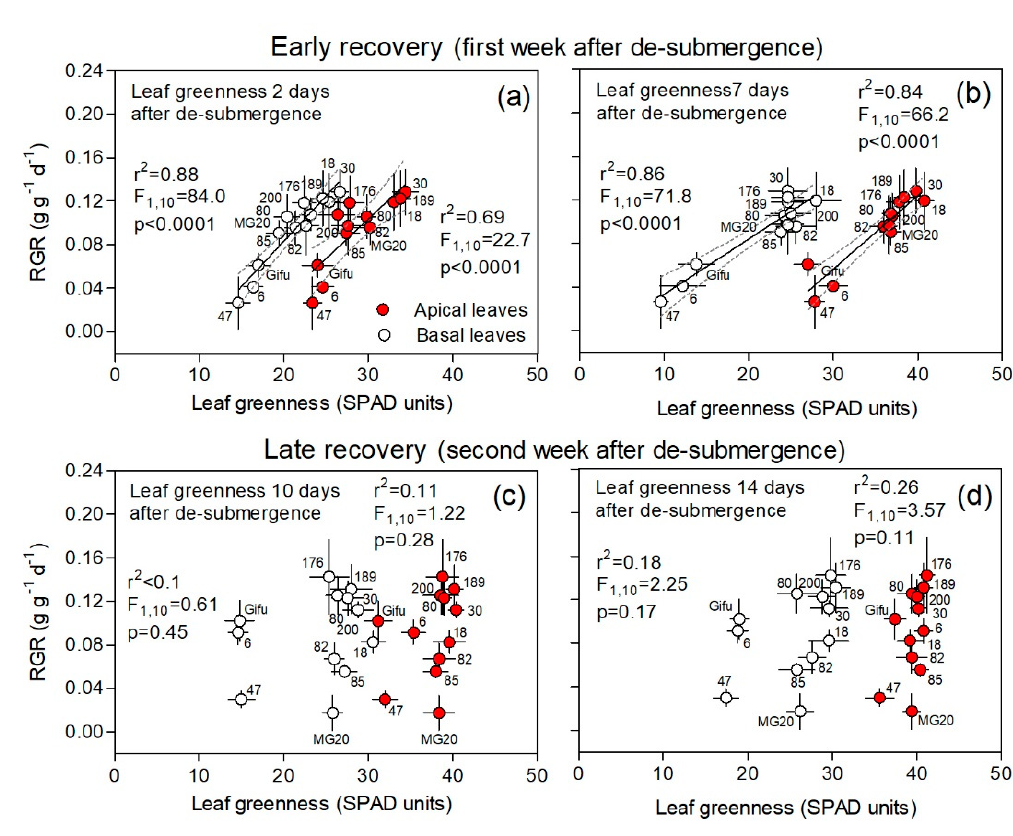
Figure 7. Plant relative growth rate (RGR) during ‘early’ and ‘late’ recovery vs. greenness (SPAD units) of basal and apical fully expanded leaves at days 2, 7, 10, and 14 after de-submergence for plants of 12 genotypes of Lotus japonicus (10 recombinant inbred lines and their parents Gifu and MG20). The first week after de-submergence was used to explore the relationship between these variables in an ‘early recovery’ phase ( a , b ) and the second week in a ‘late recovery’ phase ( c , d ). Values are means ± standard errors (n = 6–8 for RGR and n = 5 for greenness). The leaf greenness values corresponding to the control treatment ranged between 33.6 and 37.6 SPAD units for basal leaves and 33.6 and 37.6 SPAD units for apical young fully expanded leaves (all data for each genotype and measurement dates are available in Table S5).